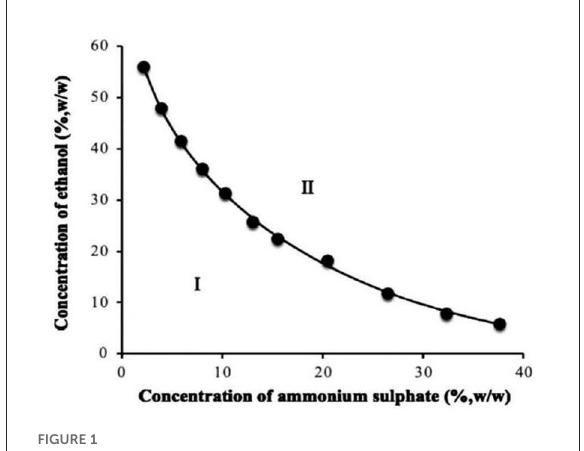
FIGURE1 Phase diagram for ethanol-ammonium sulfate aqueous two-phase